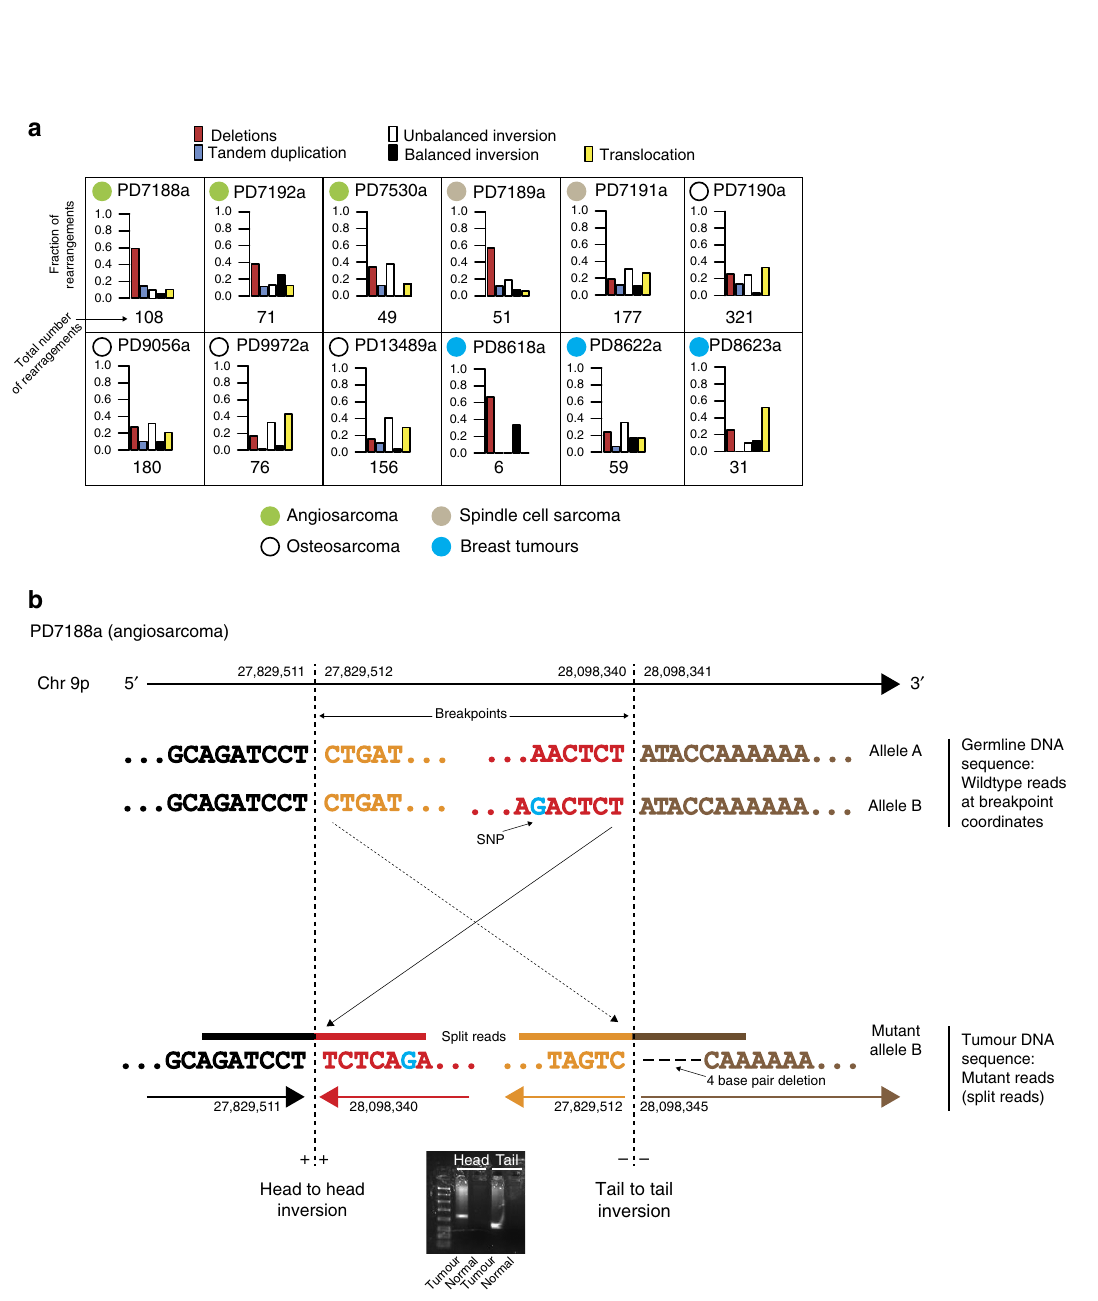
Figure 2 | Balanced inversions in radiation-associated tumours. ( a ) Overview of rearrangements. Tumours exhibited tumour-type specific features. Balanced inversions (black bars) were found in every tumour, except PD7530a. ( b ) Example of a balanced inversion in PD7188a. A 0.9Mb inversion. The inversion was validated by PCR across the breakpoint (gel image) and by split reads. Note that the split reads carried a heterozygous SNP at the head